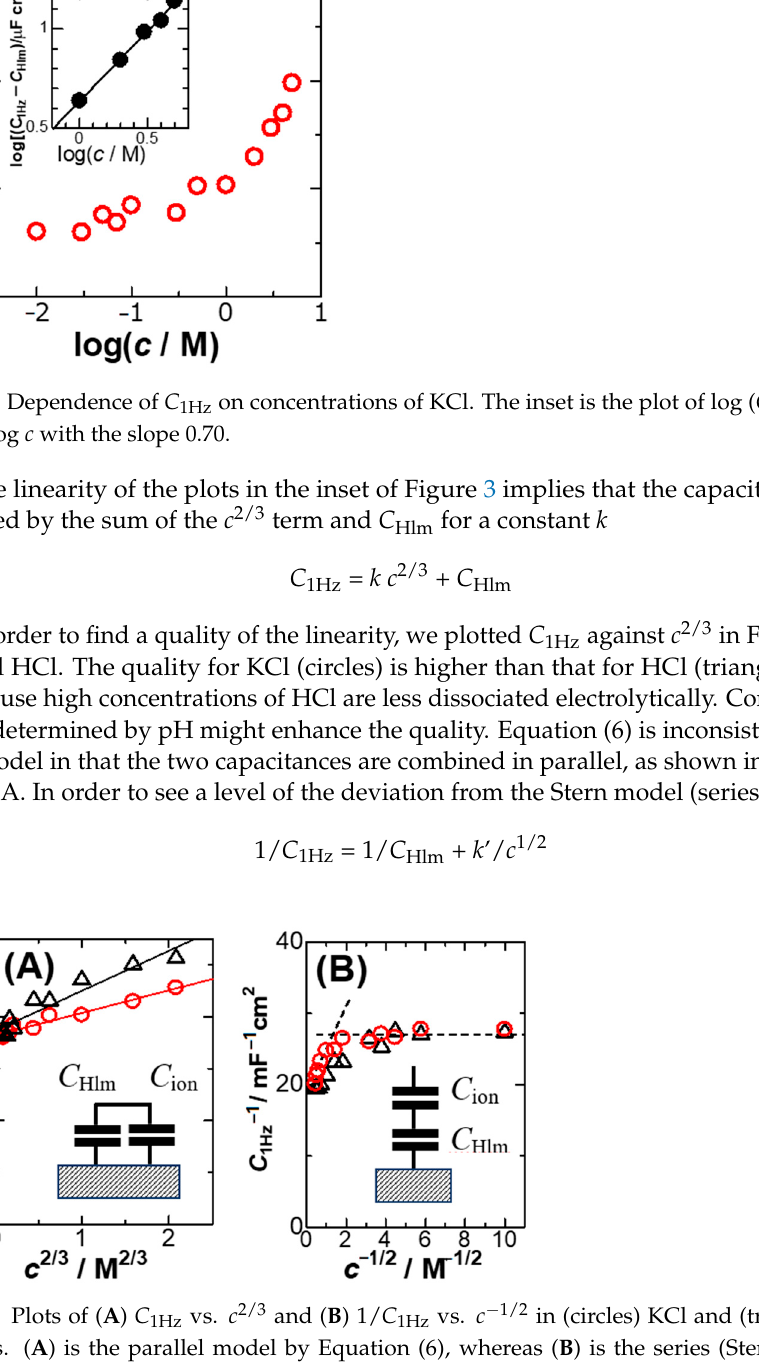
Figure 5. ( A ) Variations of C 1Hz with dc potentials ( E dc ) for c = (a) 2, (b) 3 and (b) 5 M, and ( B ) CV at the scan rate 0.05 V s − 1 in 3 M KCl solution. The dashed curve in ( A ) is by the GC theory for c = 5 M and ε r = 78. 4. Theory and Discussion Our model of DLCs is composed of C Hlm and C ion . The latter has been discussed on the basis of Poisson–Boltzmann’s distribution which leads to GC theory. The GC theory includes a failure in that it predicts condensed ions over finite sizes of ions [36] in the